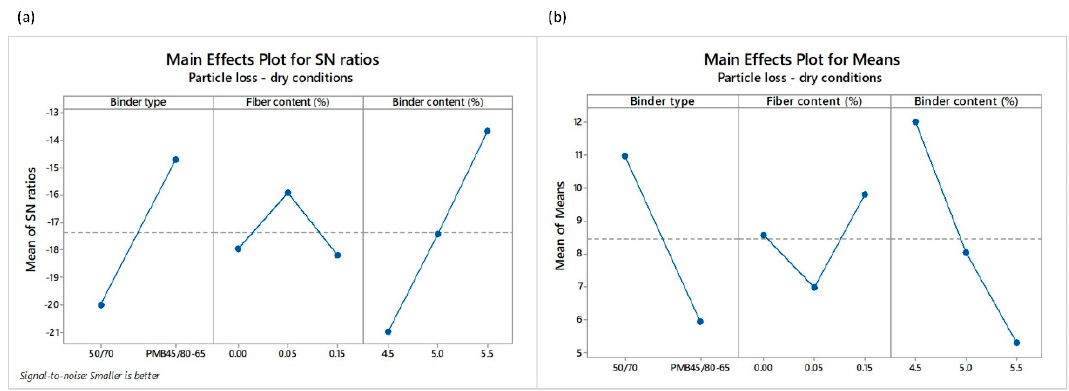
Figure 6. Main effects plots of ( a ) SNR and ( b ) means of the particle loss in dry conditions 𝑃𝐿 (cid:3005)(cid:3019)(cid:3026) . Figure 6. Main e ff ects plots of ( a ) SNR and ( b ) means of the particle loss in dry conditions PL DRY